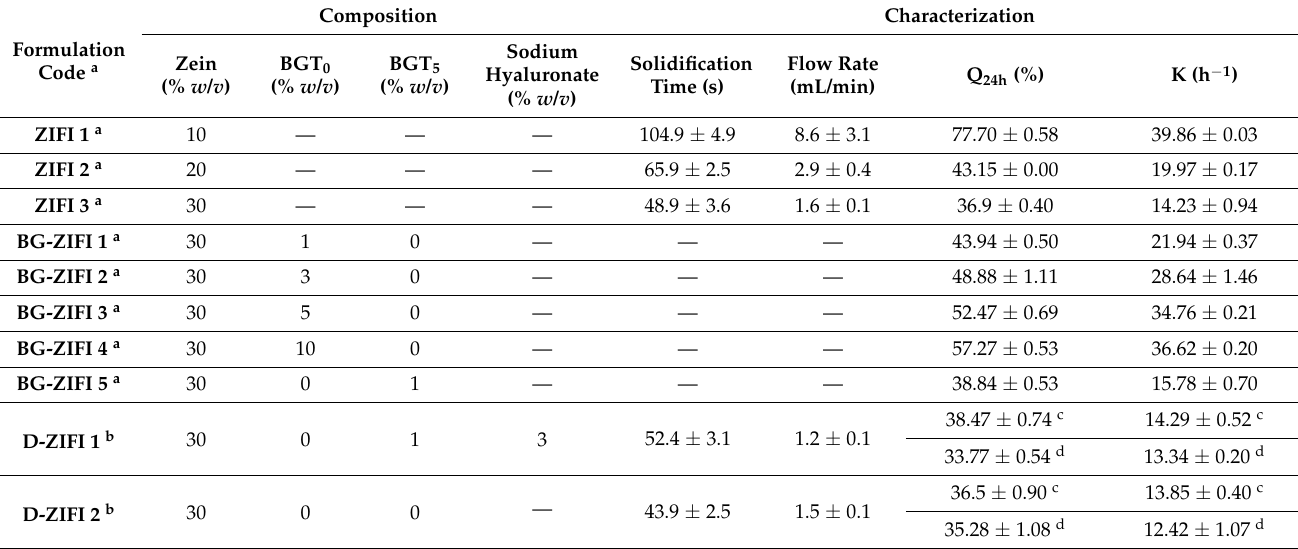
Table 1. Composition and characterization of zein in situ forming implants.